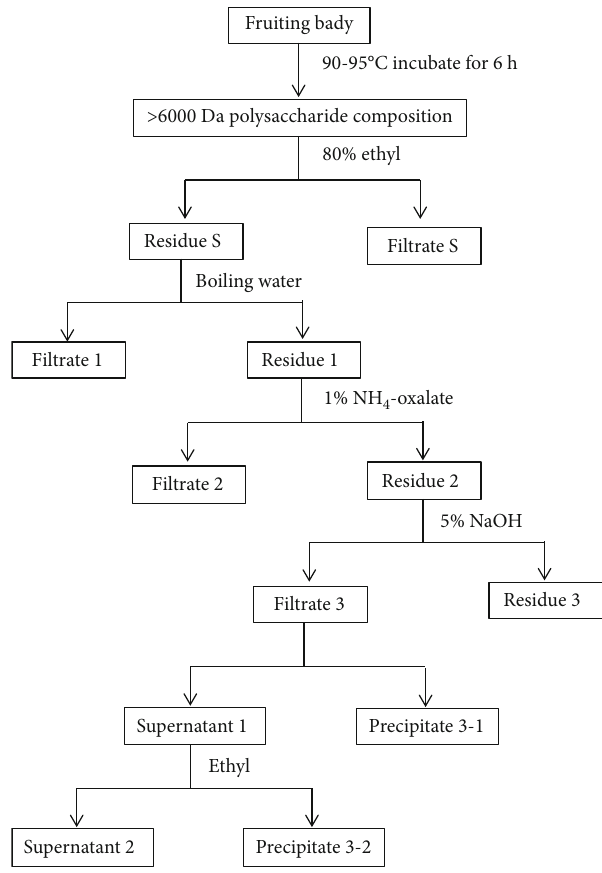
Figure 1: Extraction of lentinan from the